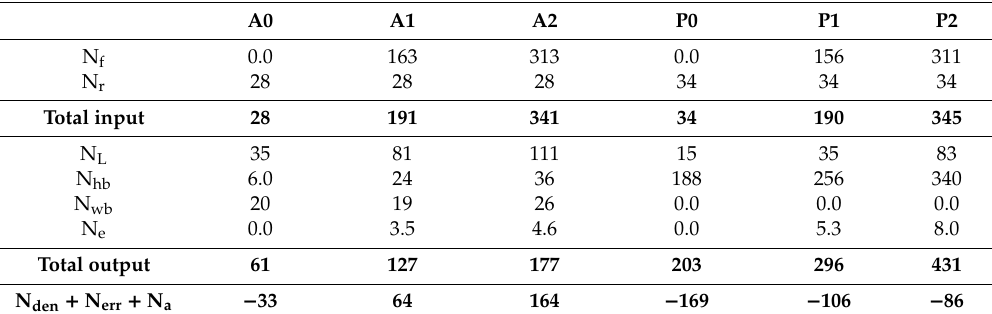
Table 6. Comparison of the N (kg ha − 1 y − 1 ) balance among the di ff erent field plots. N f = input